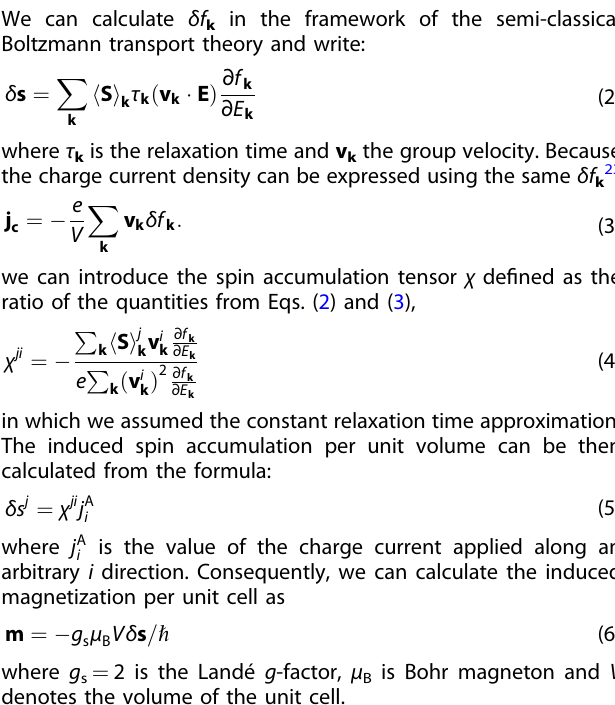
Fig. 1 Crystal structure and electronic properties of chiral tellurium. a Side and top view of the left-handed Te (SG 154). b Band structure calculated along the high-symmetry lines in the Brillouin zone (BZ), identical for both enantiomers. c Zoom on the two regions marked by the color rectangles in ( b ). The upper panel shows the set of 5 p lone-pair bands around the H point. The bottom panel illustrates the details of the topmost valence band. d Brillouin zone with the high-symmetry points and Fermi surface at E = − 30 meV; the inset shows a zoom-in of the dumbbell-shaped hole pocket at the H